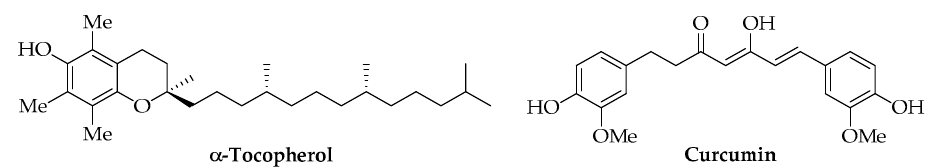
Figure 7. Chemical structure of α -tocopherol and curcumin.